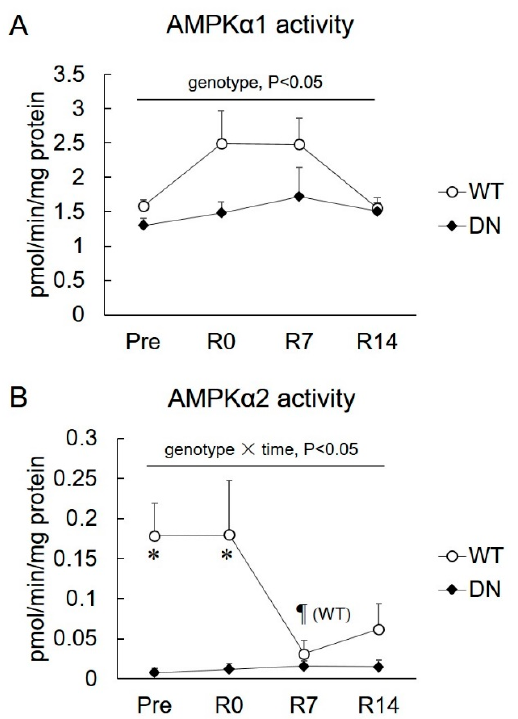
Figure 2. Changes in the isoform-specific 5 ′ AMP-activated protein kinase (AMPK) activity after 14 days of hindlimb unloading, and at 0, 7, and 14 days of reloading. ( A ) AMPK α 1 activity. ( B ) AMPK α 2 activity. Values are means ± SE; n = 7–8 per group. Statistical results of two-way ANOVA (genotype, time, and genotype × time) are described in the Figure. *, significant difference between genotypes at same time point. ¶, significant difference from R0 independent of genotype, unless special mention in Figure.